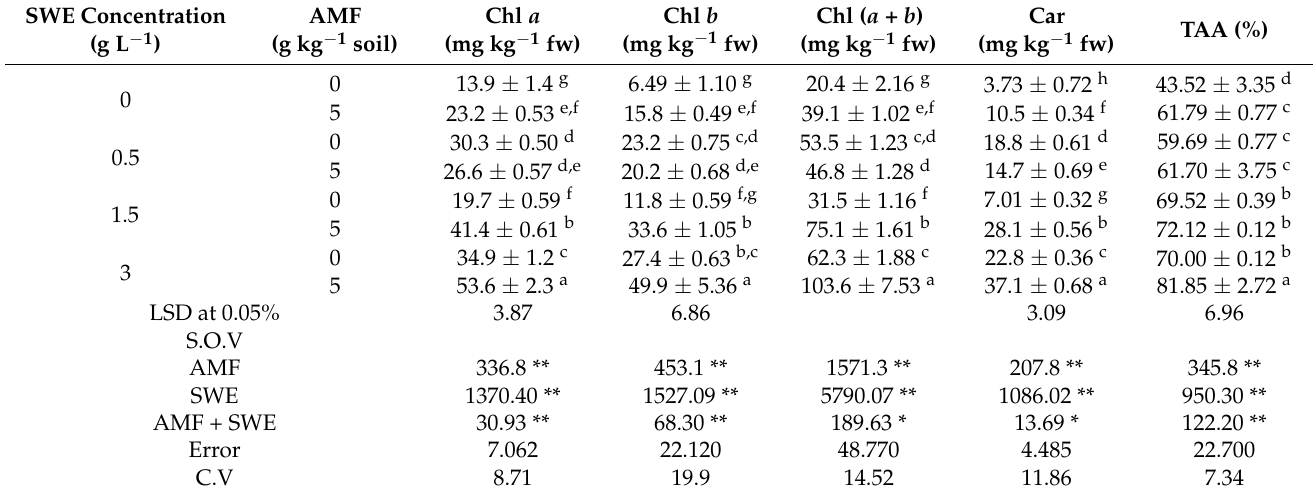
Table 2. The effect of arbuscular mycorrhiza fungi (AMF) inoculation and seaweed extract (SWE) foliar application on the photosynthetic pigments contents of lettuce plants and their